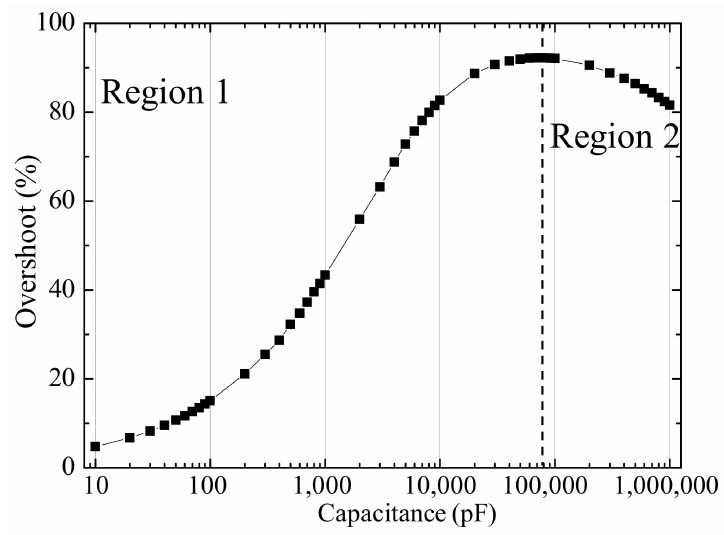
Figure 9. Overshoot with different capacitances.